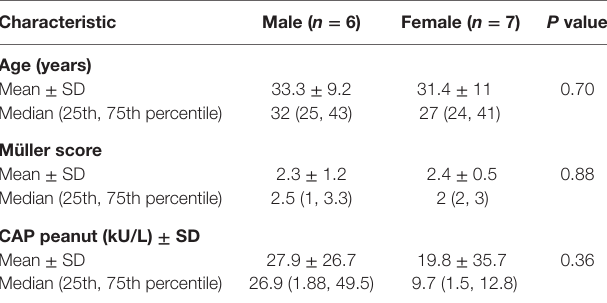
TaBle 2 | Demographic data of male and female patients. characteristic